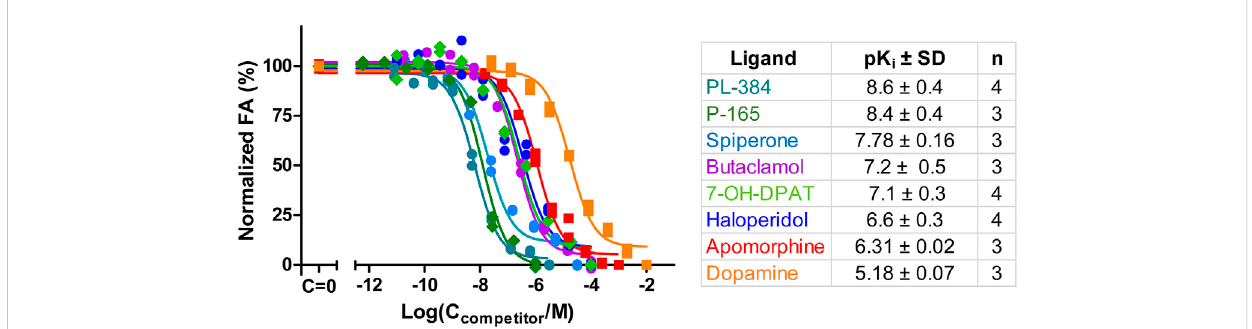
FIGURE 4 Displacement of CELT-419 binding to D 3 receptor by different dopaminergic ligands. Change in FA level was measured after incubation of 0.5 nM CELT-419, 1 μ L BBV/well (C D3R = 0.7 nM), and different concentrations of corresponding dopaminergic ligands for 180 min. The FA values were normalized by taking the average FA value of C = 0 points as 100% and the average FA value of the highest used concentration points as 0%. Data of a representativeexperimentfromatleastthreeindependentexperiments,performedinduplicates,isshownwithbothreplicatesdisplayed.pK i values are calculated as described in (Veiksina et al., 2014), and presented as mean ± SD of n independent